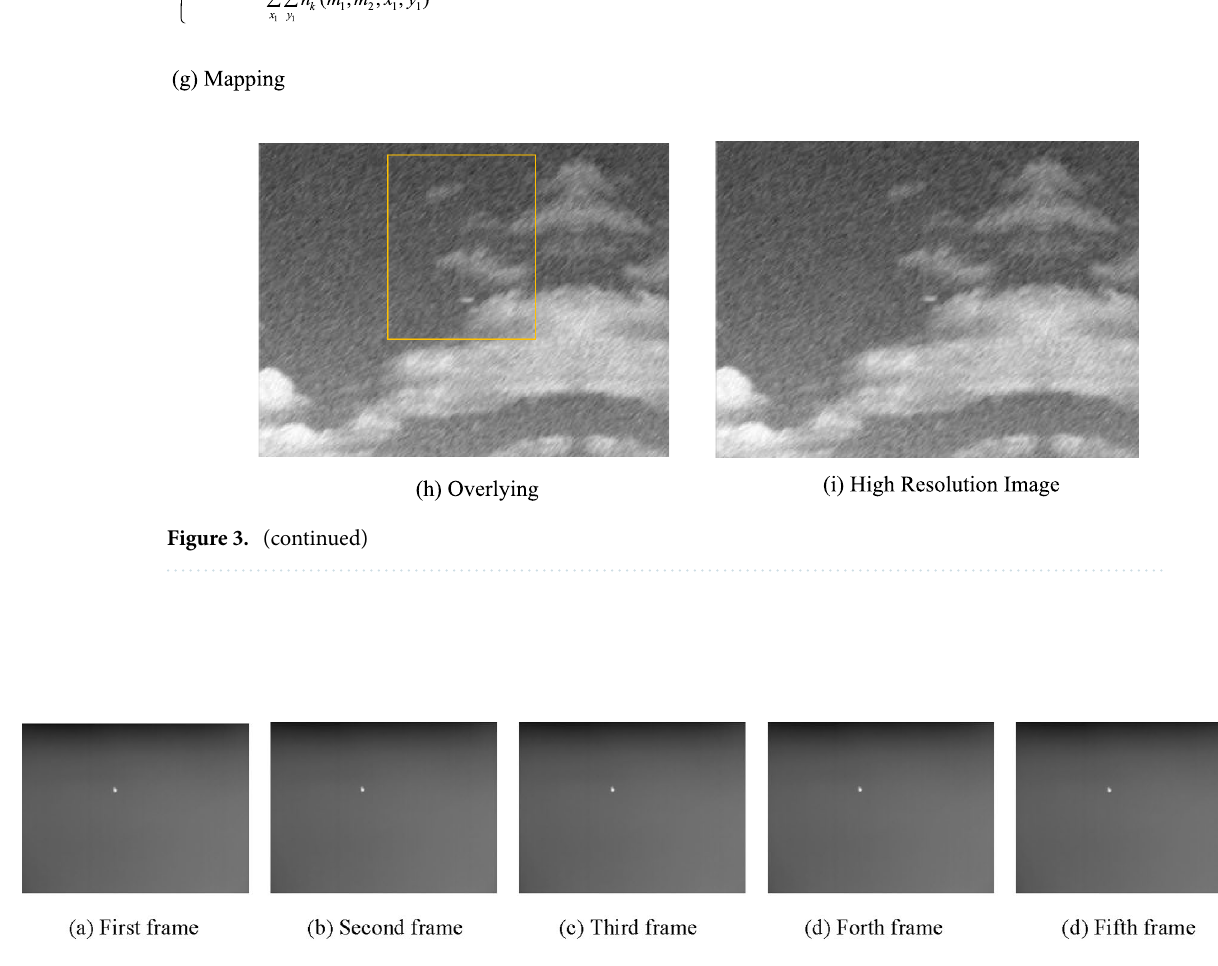
Figure 4. Low resolution image sequences of plane image in sky